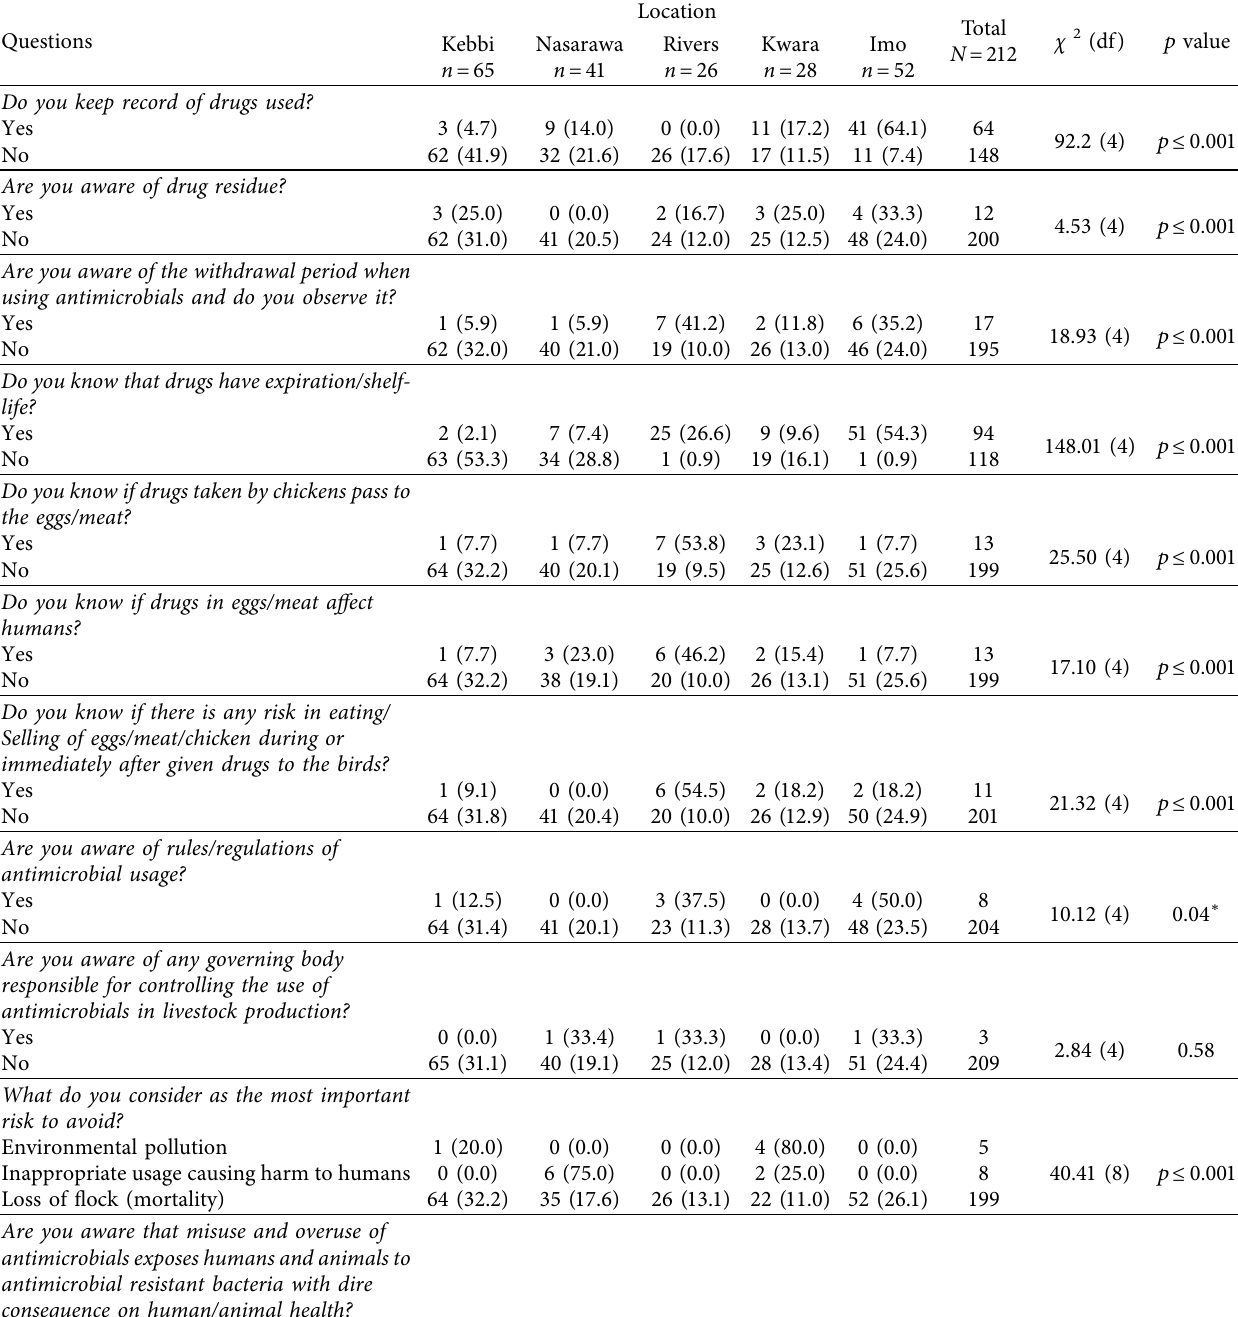
Table 2: Farmers knowledge and awareness of the implications and risk of